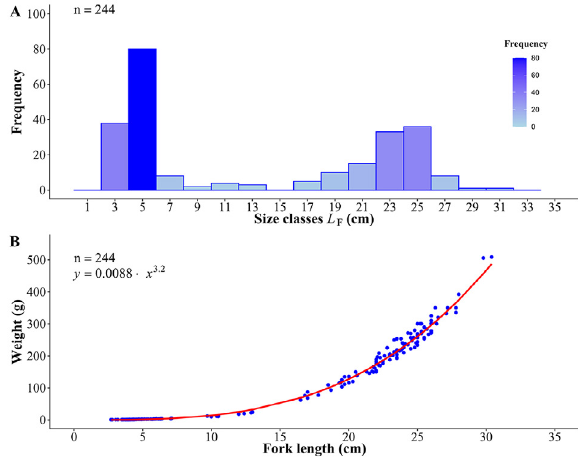
Fig. 3. – Graphic representation of L frequency (A) and non-linear F M - L length-weight data (B). Sample size (n) and equation are also F reported.